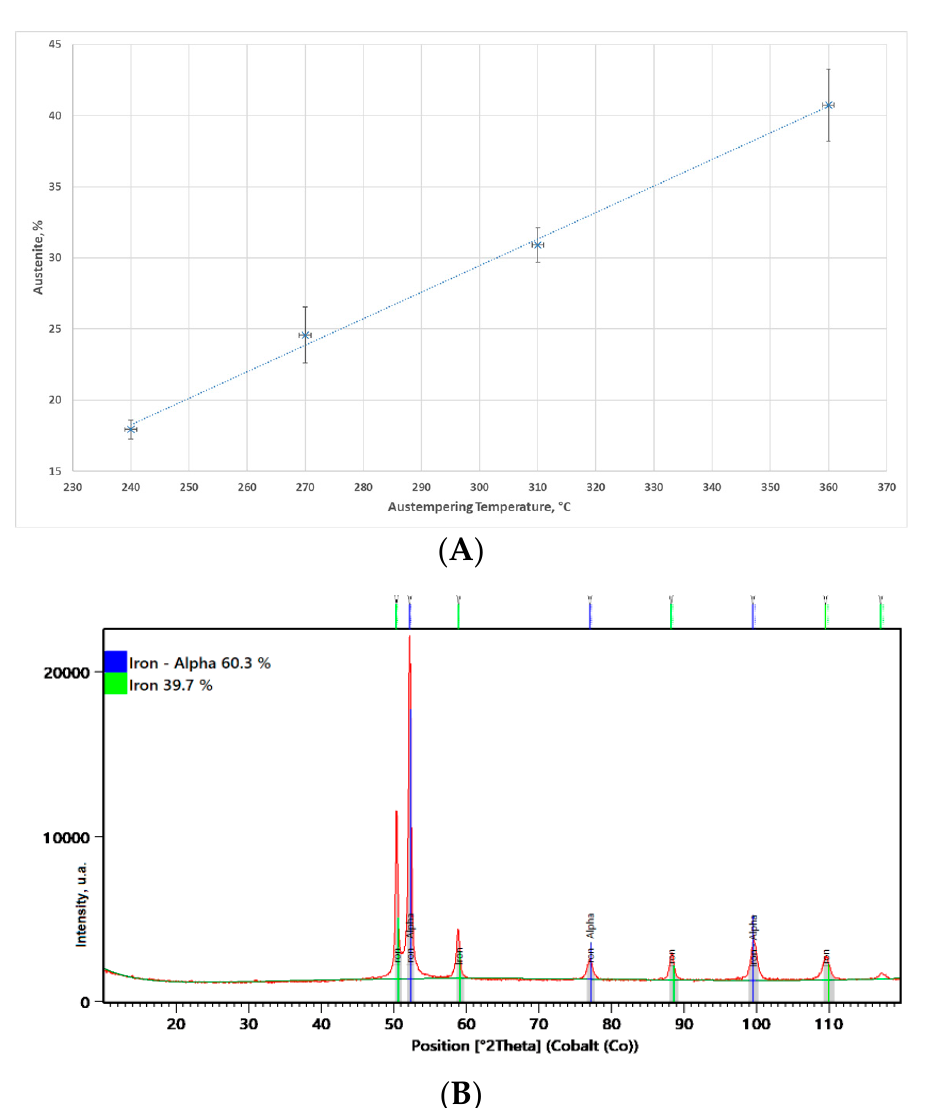
Figure 4. Austenite content. ( A ) Graph of the austenite content in the tested ADI matrix in a function of the austempering temperature. ( B ) Sample of X-ray diffractogram for ADI_360 cast iron.